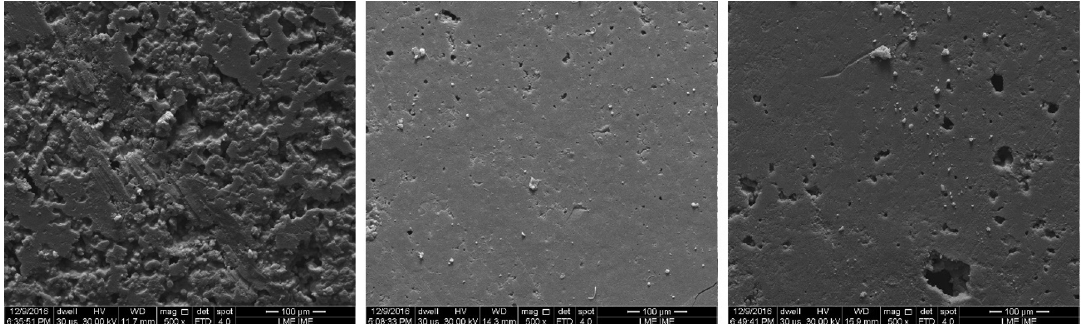
Figure 13. SEM electron micrographs of the surfaces of the PET/U-GCW composites: (a) 50/50 (b) 60/40 and (c) 80/20.